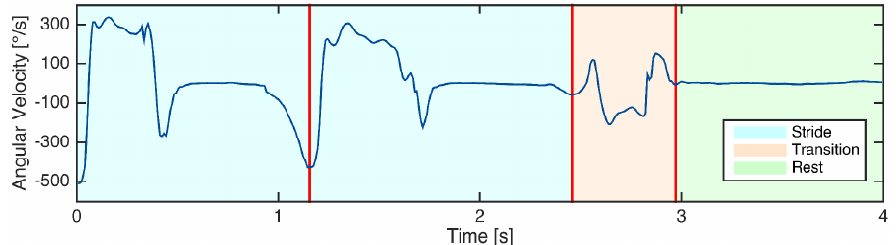
Figure 3. Labeling of an example of gyroscope signal including two strides, the following transition (non-stride) movement, and